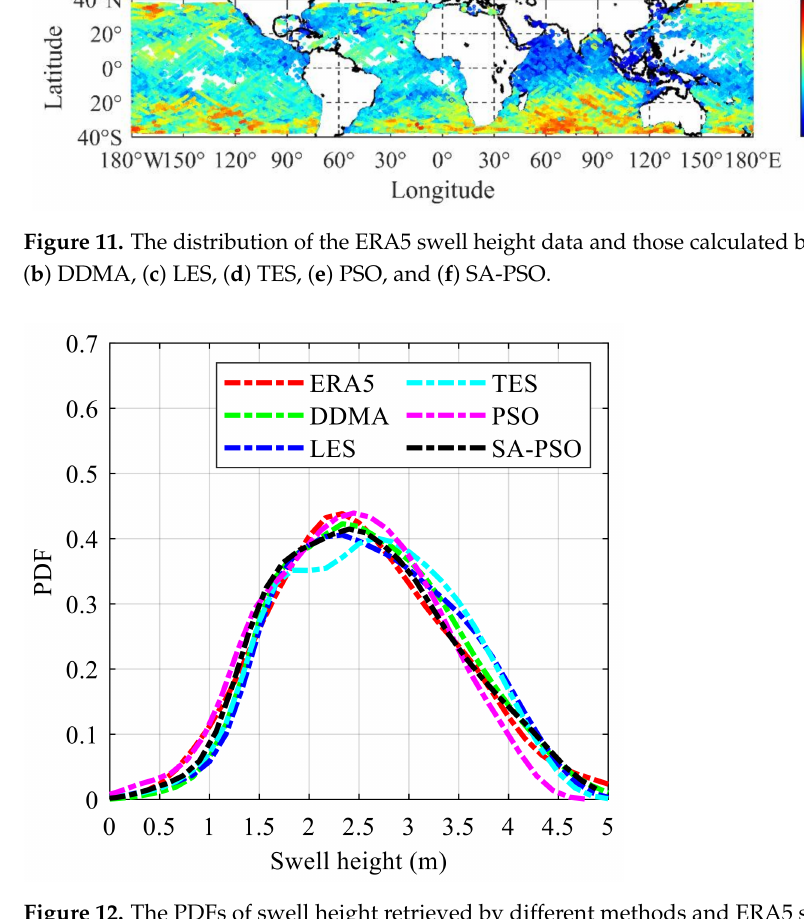
Figure 12. The PDFs of swell height retrieved by different methods and ERA5 swell height. Table 3. Mean and standard deviation of swell height estimated by different